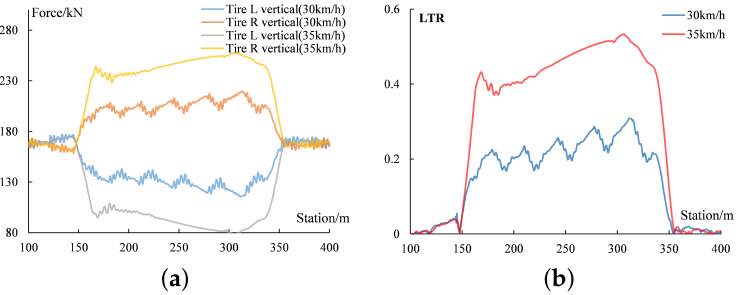
Figure 8. ( a ) Lateral vertical load distribution and ( b ) LTR value of the left and right tire for wind speeds of 74